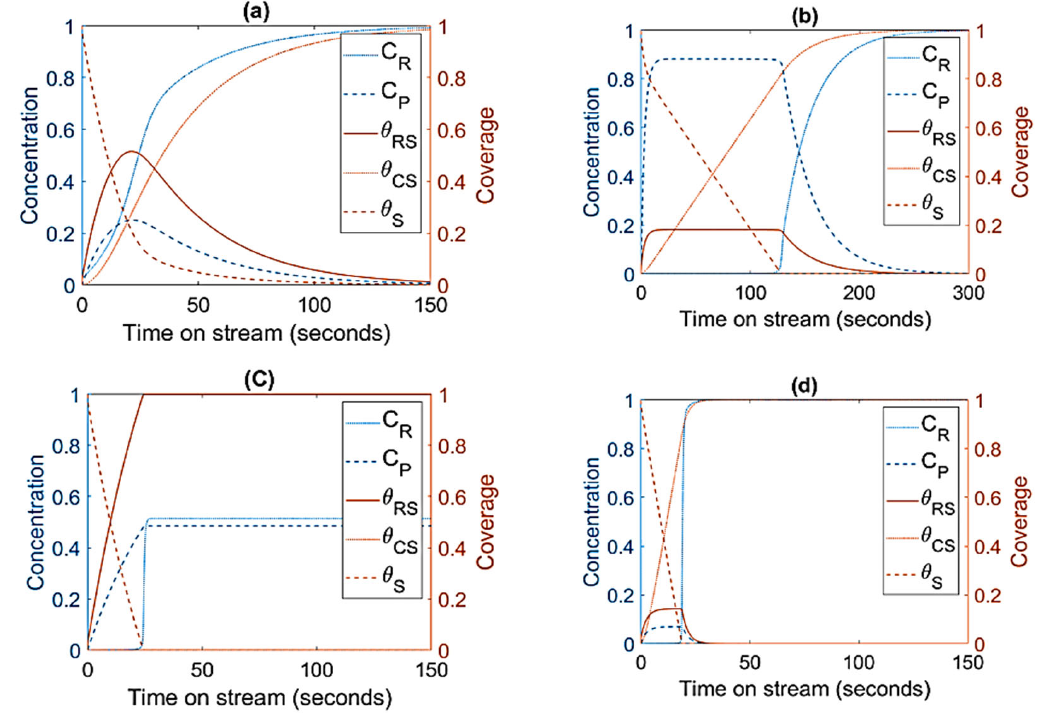
Figure 5. Estimated reactant and product concentration profiles ( left y -axis ) and surface species coverages ( right y -axis ) with respect to time: sensitivity analysis for Mechanism I, ( a ) with reduced k 1 by 100% and increased k − 1 by 10% ( b ) increased k 2 by 10% ( c ) k C = 0.36 ( d ) τ = 5